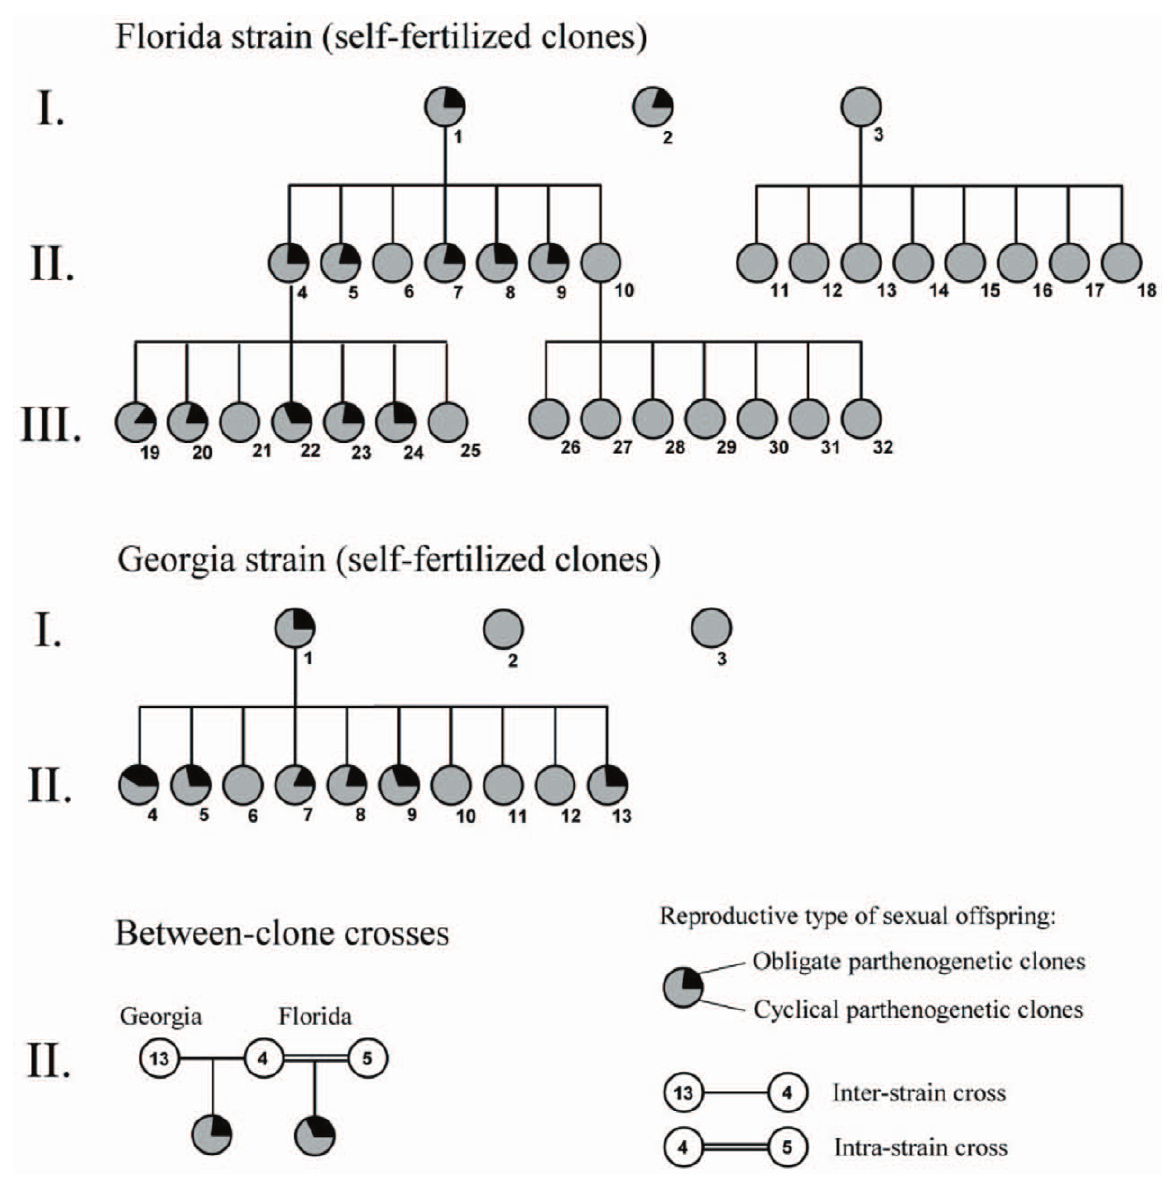
Figure 1. Mendelian inheritance of obligate parthenogenesis in two strains of the rotifer Brachionuscalyciflorus . The figure shows an overview of all experimental clones, represented by numbered pie charts, which were propagated either by self-fertilization or experimental crosses. Roman numbers indicate successive sexual generations; Arabic numbers indicate individual clones of the two rotifer strains. Pie charts display the proportion of obligate vs . cyclical parthenogens among the sexually produced offspring clones of each clone. We analyzed 45 clones and determined the reproductive type in 88 6 5.2 (s.e.m.) of their sexual offspring clones, giving a grand total of 3962 analyzed clones.